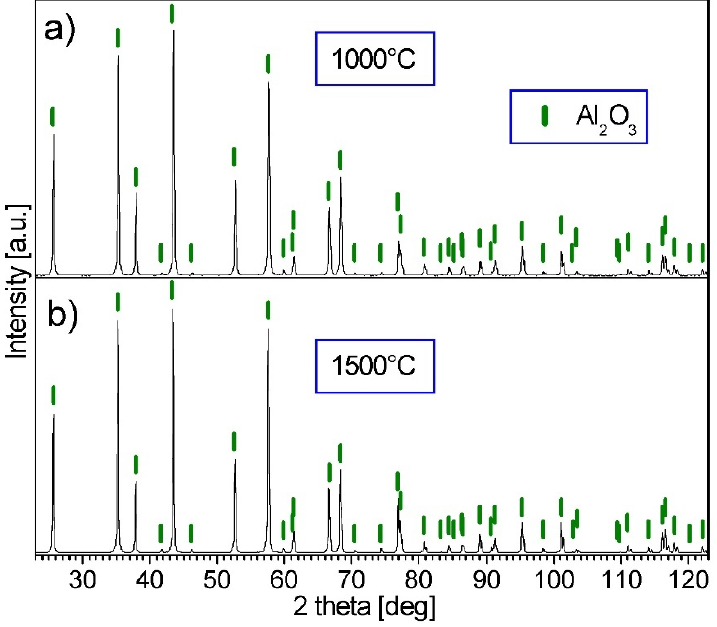
Figure 6. XRD patterns of the A 2 O 3 powder after consolidation by PPS: ( a ) at 1000 °C; ( b ) at 1500 °C.